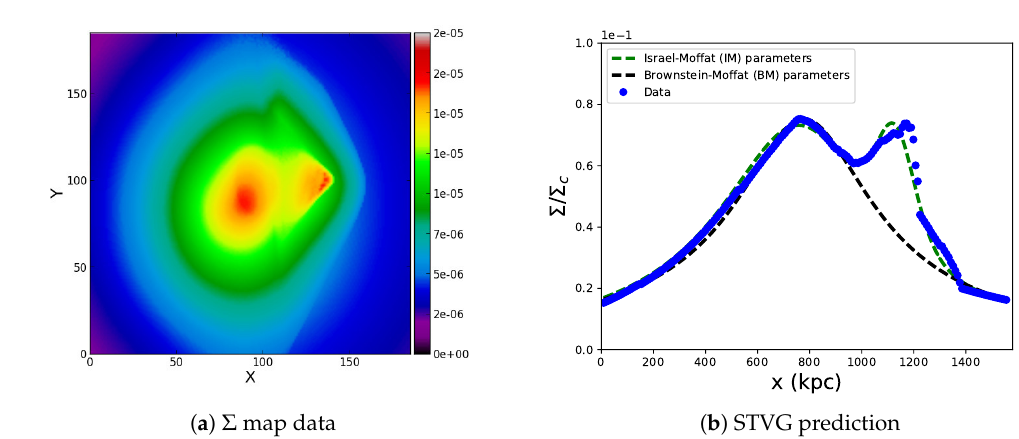
Figure 3. Surface density map of the Bullet Cluster (BC) ( left ) and 2D projection of the surface density plot ( right ). The subcluster is the shock wave front on the right (in top plot), while the main cluster is on the left (top plot). The colour scale corresponds to the mass in units of 10 15 M (cid:12) and has a resolution of 8.5 kpc pixel − 1 . This is based on a redshift measurement of the BC of 260 kpc arcmin − 1 . In the 2D projection (bottom), the green dotted curve is the fit to the main and sub-cluster data (blue points) as a double- β model. The black dotted curve is the single- β model fit using the Brownstein–Moffat parameters. STVG,